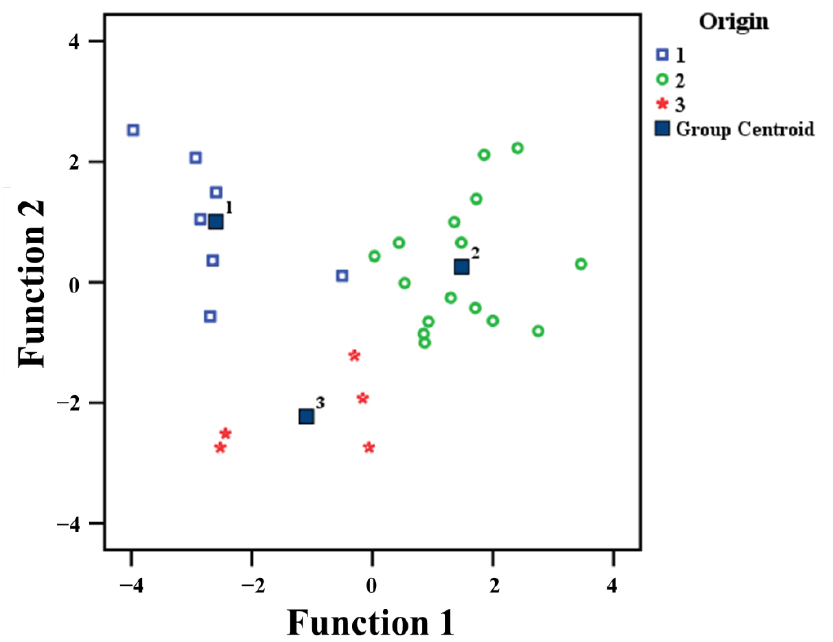
Figure 5. LDA of isotopic and elemental compositions using five markers for determining the geographical origins of THMR cultivated in three contiguous provinces in Thailand covering YP, RP, and SP. Empty squares, circles, and stars symbols refer to (1) YP, (2) RP, and (3) SP, respectively. Filled squares represent the group centroid of each province.